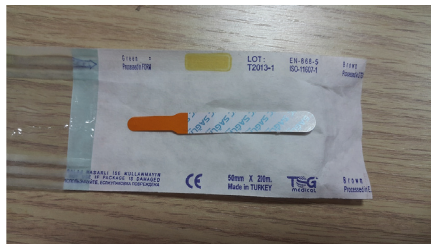
Figure 2: Fluorescein